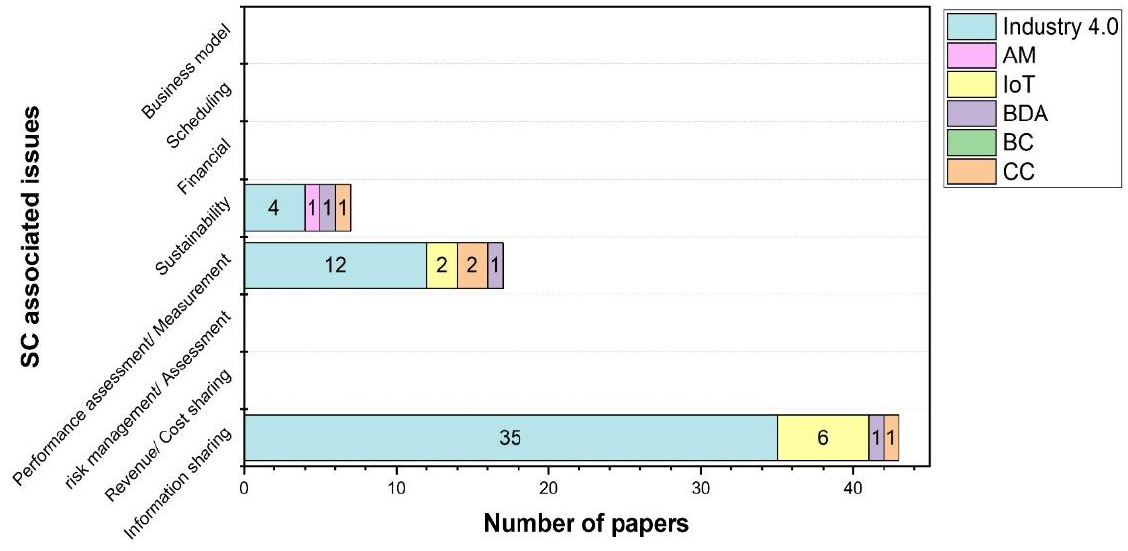
Figure 6. Distribution of papers: SC-associated issues .